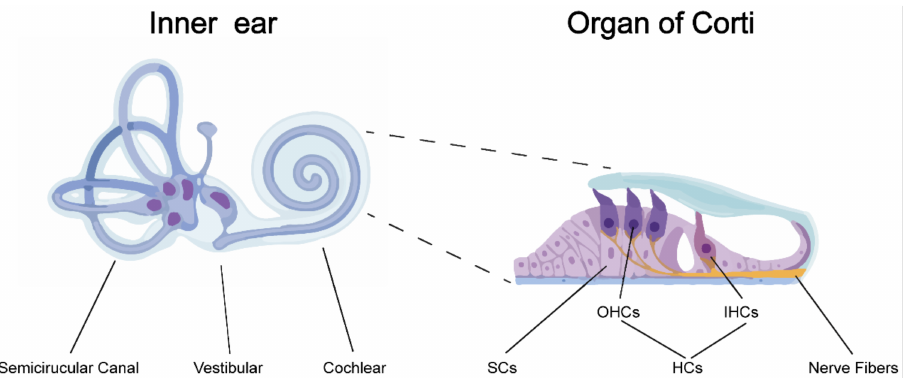
Figure 1. Anatomy of the inner ear and the organ of Corti. The inner ear is divided into three sections: the semicircular canals, the vestibular and the cochlear. The organ of Corti is located inside the cochlear duct, responsible for transducing sound vibrations into nerve impulses. The organ of Corti consists of three rows of outer hair cells (OHCs) and one row of inner hair cells (IHCs) interspaced by supporting cells